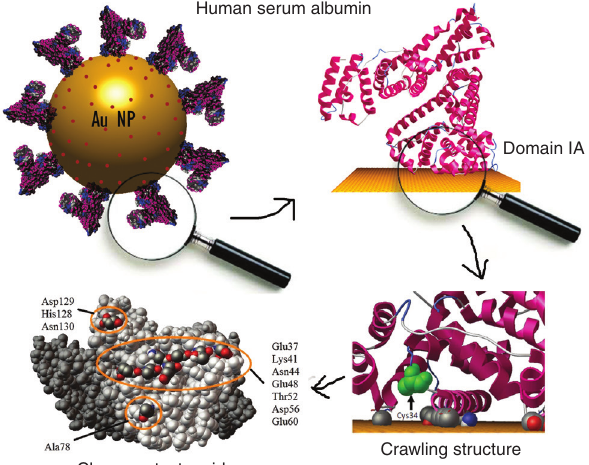
Figure 2 The human serum albumin binds on the gold NP surface with a preferred orientation. The surface of a 40-nm gold NP appears to be flat for the small protein, which anchors itself with the domain IA region forming a crawling-like structure. The contact amino acid residues or the footprints of the protein have been indi- cated in the diagram. The cystine34 residue remains a bit away from the surface as it is slightly buried inside the